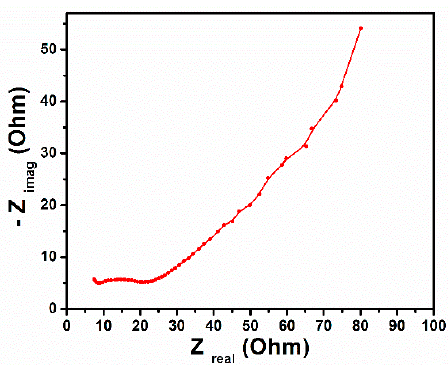
Figure 7. Electrochemical impedance spectra of TiO 2 nanotube arrays from 100 kHz to 1 Hz in the form of Nyquist plots.